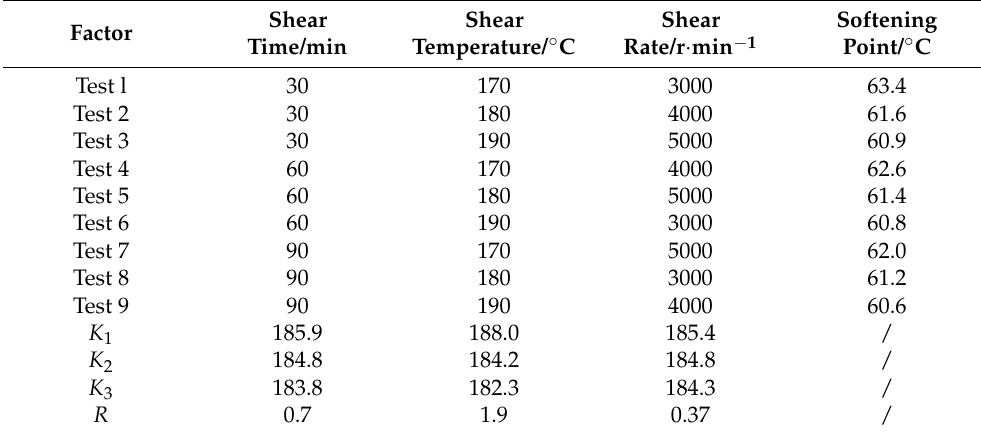
Table 10. PE Calculation results of softening point test R and K values of PP modified asphalt. Factor